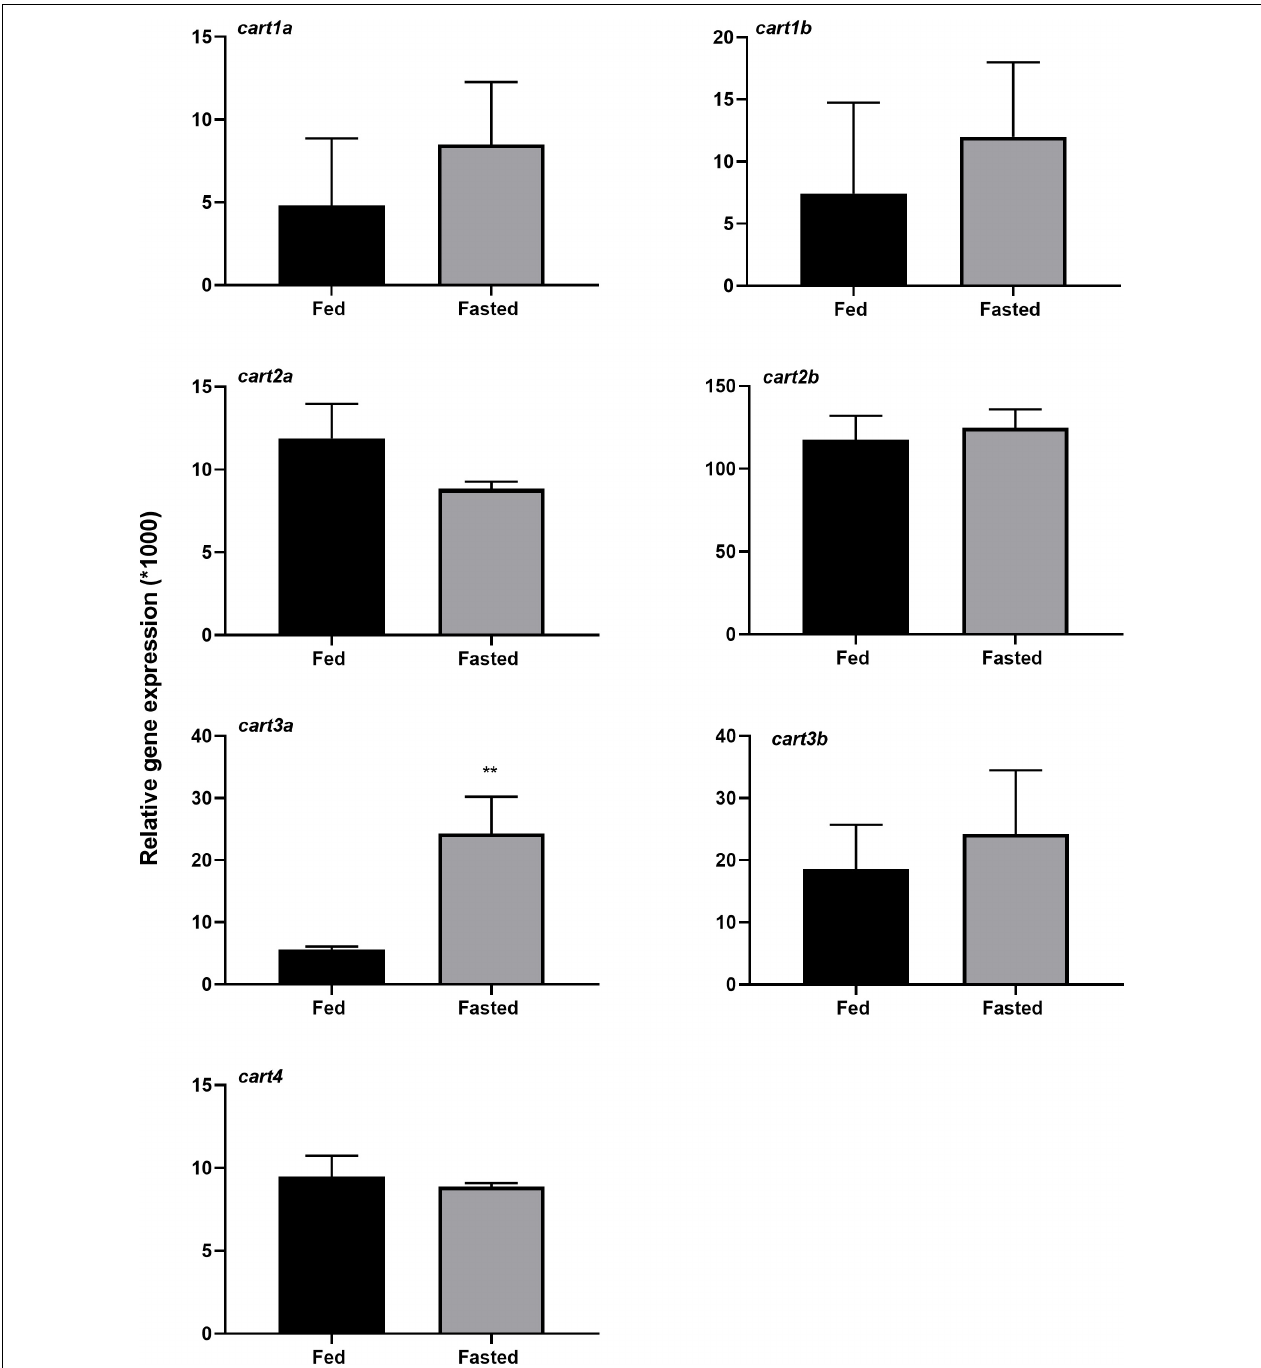
FIGURE 5 | Effect of 3 days of fasting on mRNA expression of cart paralogs in hypothalamus of Atlantic salmon. Black and gray bars represent fed ( n = 5–6) and fasted ( n = 5–6) groups, respectively. The graphs show the normalized cart mRNA copy number to the geometric mean copy number of actin β and s20 . Two-tailed t -test and non-parametric Mann-Whitney test was performed to assess the statistically significant differences between the two groups. The error bars represent mean ± SEM and asterisks show the significant level (** p < 0.01).